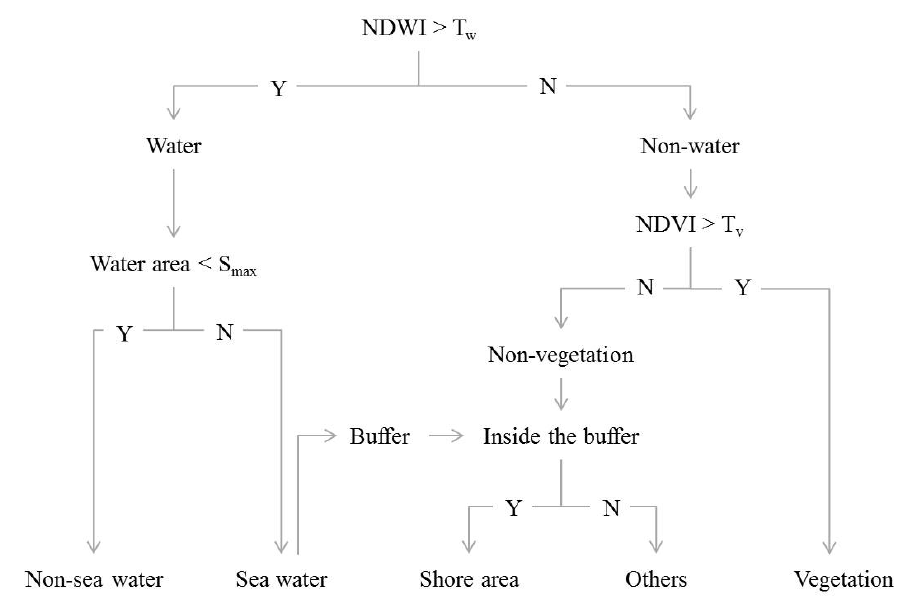
Figure 5. Decision tree for the initial